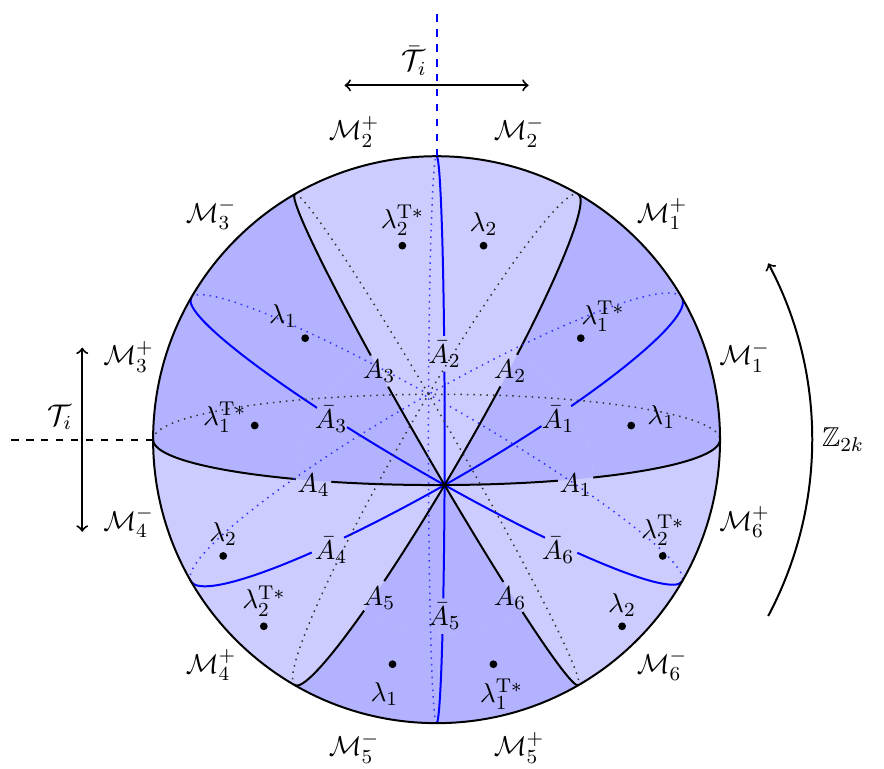
Figure 6. The 2 k -replicated manifold on which the path integral for the replicated (cid:12)delity F k is performed. The arrows show the actions of Z 2 k replica symmetry, and the two types of Z 2 + C symmetry called T i and (cid:22) T i . (The case shown is for k =